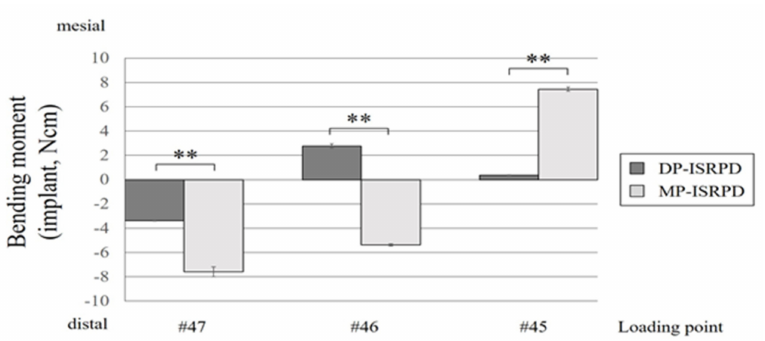
Figure 7. Bending moment (Ncm) of implant under each loading point (#45, #46 and #47) in mesially positioned implant-supported removable partial denture (MP-ISRPD) and distally positioned implant- supported removable partial denture (DP-ISRPD). Error bars represent the standard deviation, and statistical analyses are described as ** p < 0.01, t